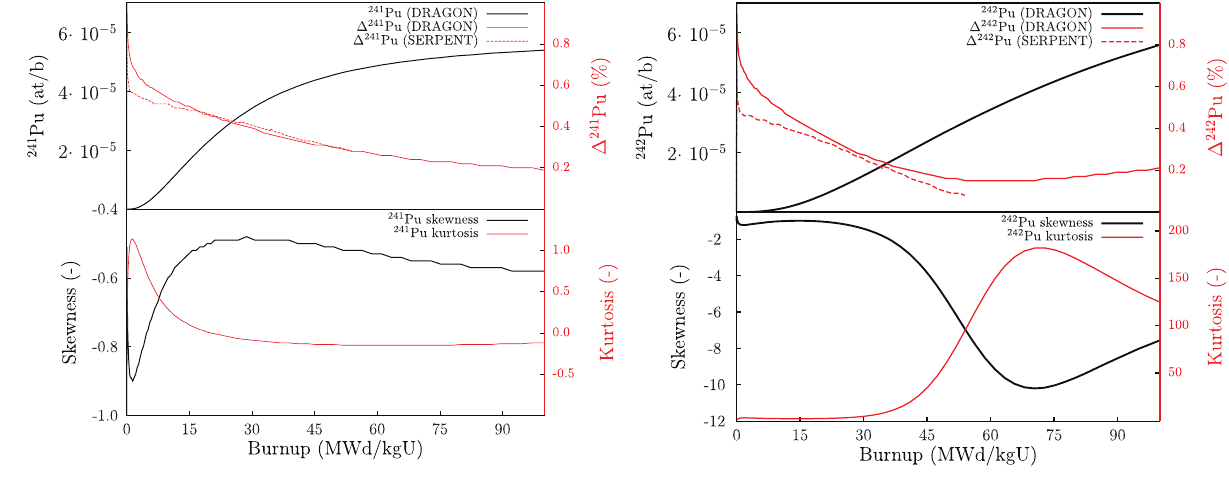
Fig. 4. Same as Figure 3, but for 241 , 242